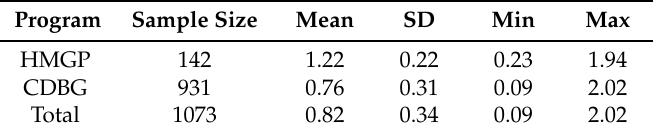
Table 5. Descriptive statistics for the relative recovery ratio.